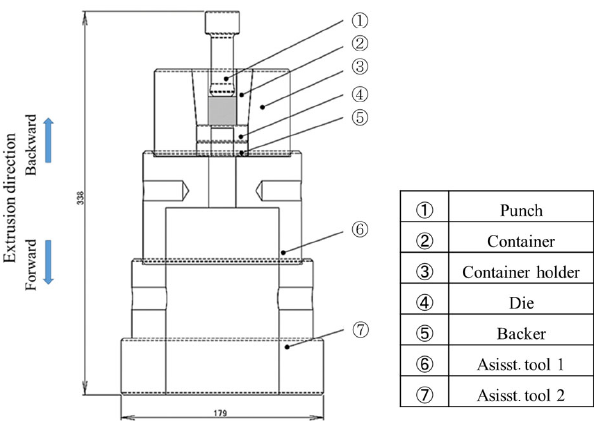
Fig. 4 Assembly drawing of hot forward–backward extrusion friction test tool.